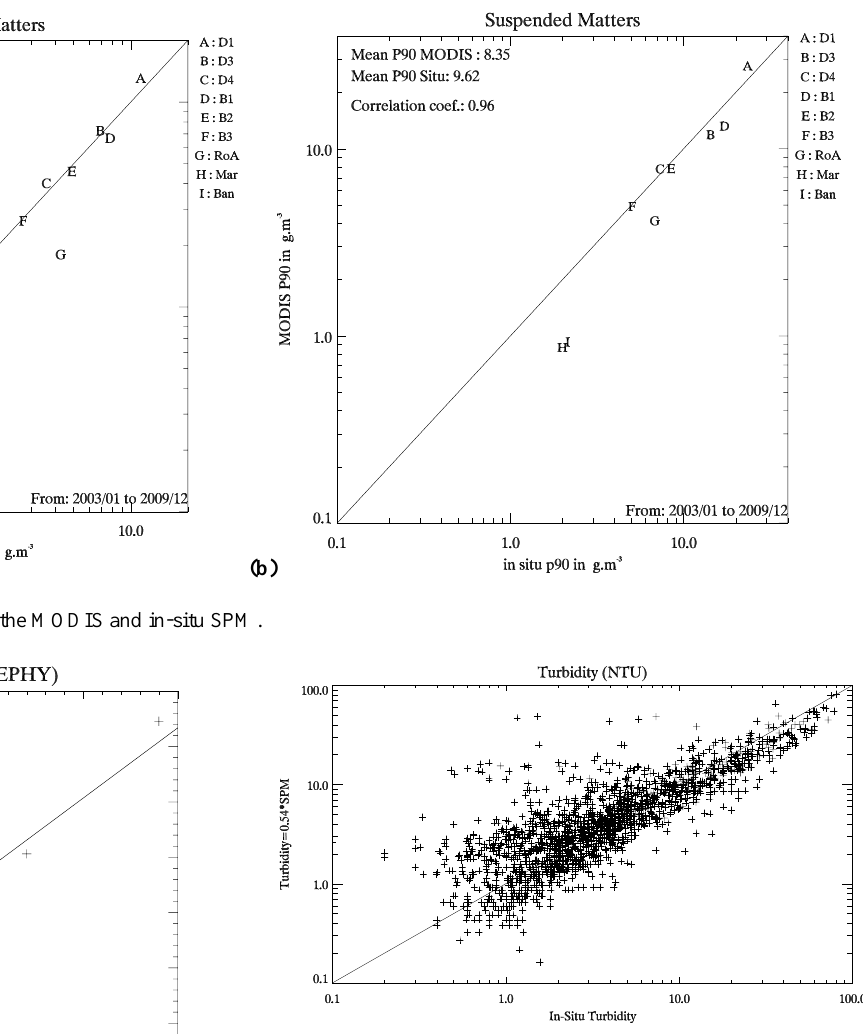
Fig. 10. The scatterplot of turbidity derived from total SPM by Eq. (5) versus observed turbidity (in-situ data collected at the north- ern SRN